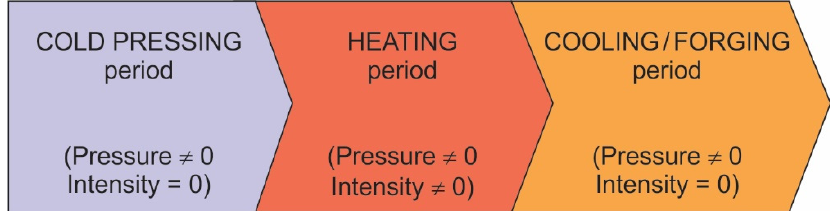
Figure 3. Typical sequence in an MF-ERS experiment, showing the pressure, and current intensity in the different stages. In all the experiments, the cold-compaction and cooling periods lasted 1000 and 300 ms, respectively.